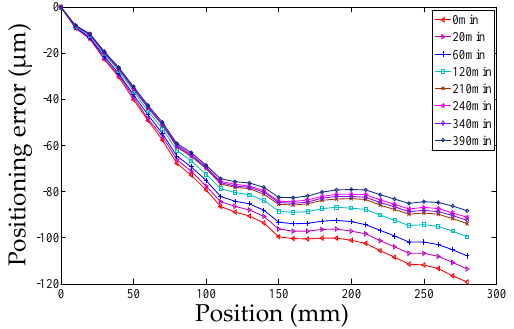
Figure 1. Y axis positioning error under different temperature conditions.